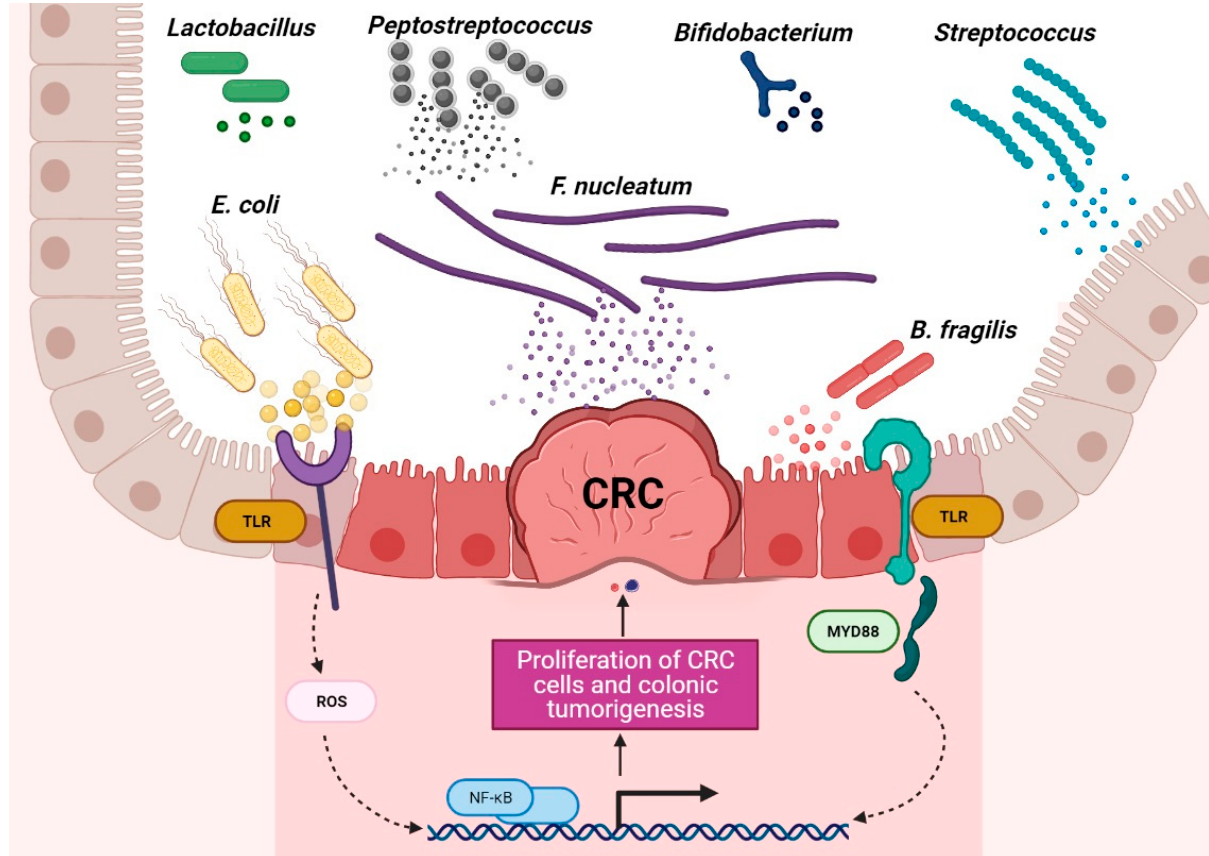
Figure 1. Schematic of the roles of probiotic and harmful bacteria in CRC context. Disruption of the gut microbiota balance is associated with CRC development, and regulation of probiotic bacteria is associated with CRC remission. (The figure was created with Biorender.com).